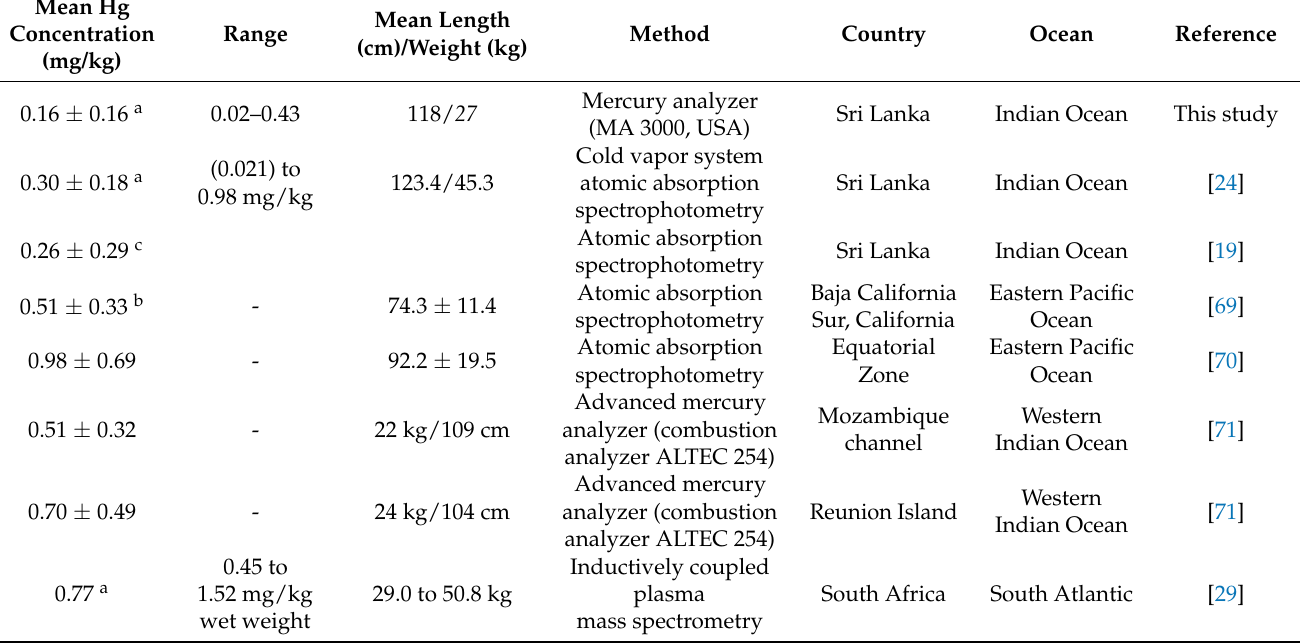
Table 1. Comparisons of the inorganic mercury concentrations in yellowfin tuna ( T. albacares